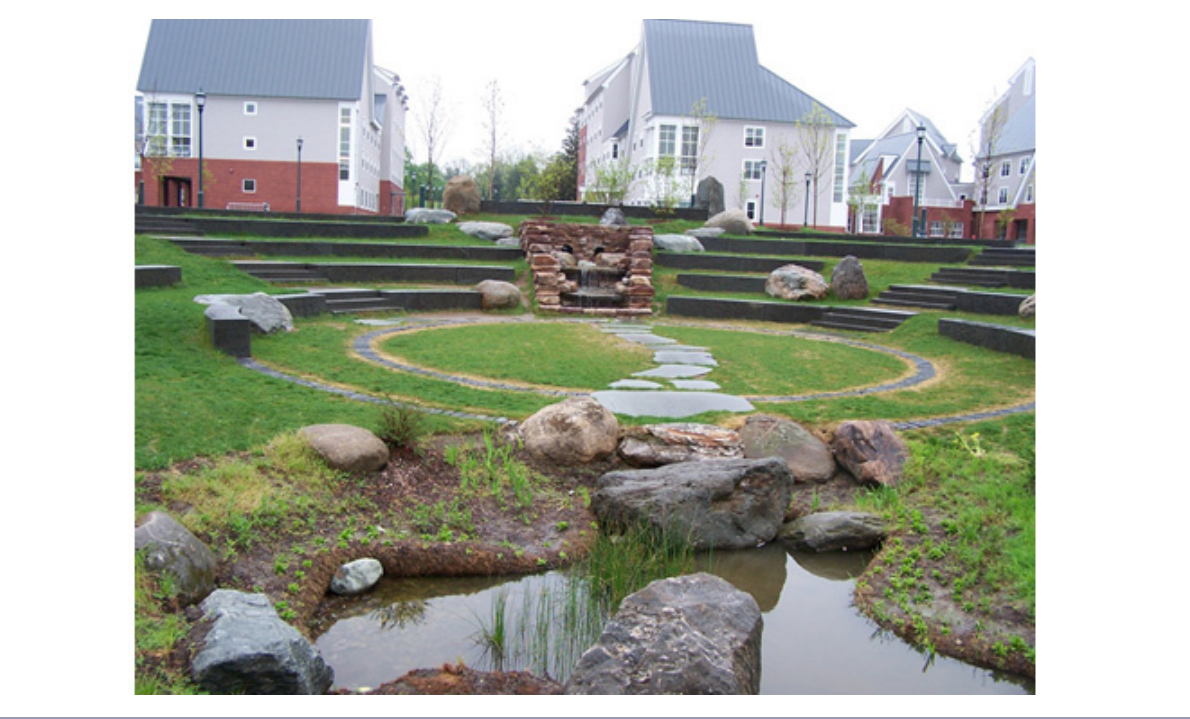
Figure 5. Multifunctional stormwater treatment feature in the residential dormitory green space at the University of